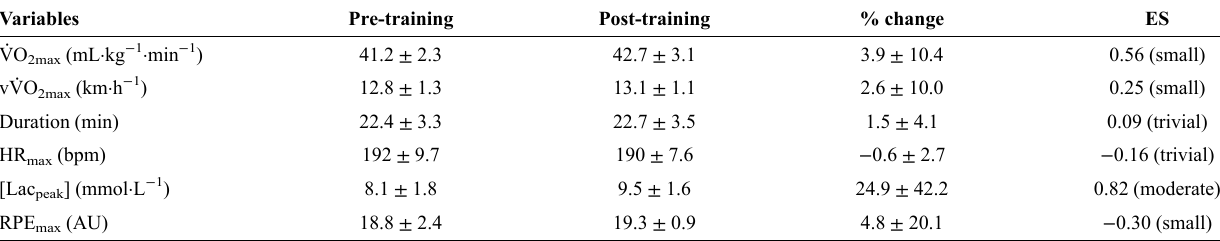
Table 3 - Physiological and performance variables obtained during the incremental test for V ̇ O 2max determination at pre- and post-training (mean ± SD) (n = 8).